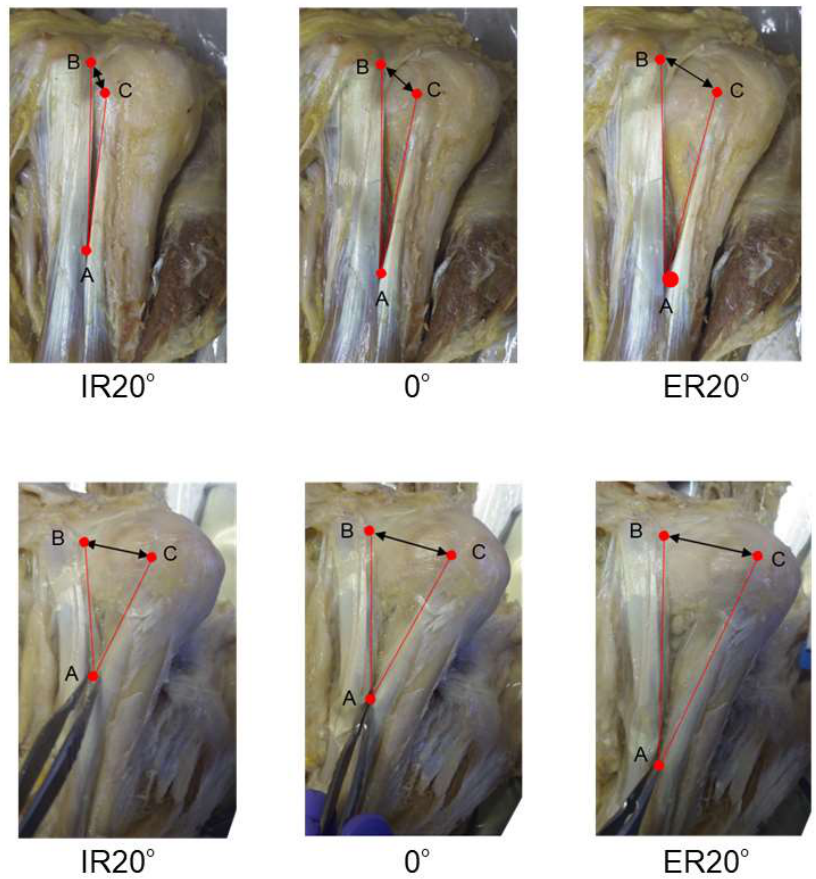
Figure 3. Photograph of the angle of confluence between the LHBB and SHBB (Angle A). In the case shown in the upper panels, Angle A increases during ER. In contrast, in the case shown in the lower panels, Angle A decreases during ER. ER, external rotation; IR, internal rotation; LHBB, long head of the biceps brachii; SHBB, short head of the biceps brachii.